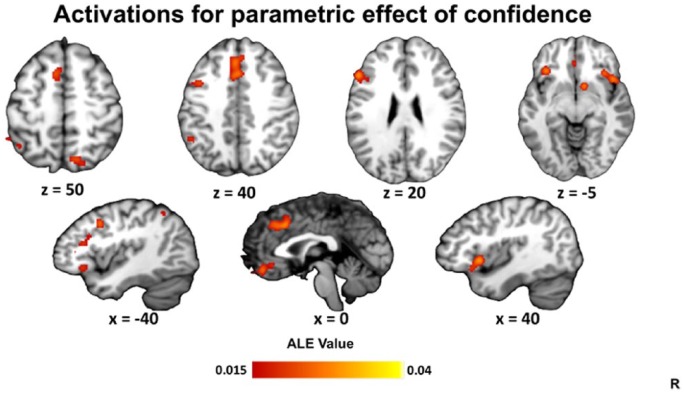
ALE results for parametric effects of confidence. Clusters are displayed
in MNI standard space. Multiple-comparisons correction was applied at
the cluster level at a family-wise error-corrected threshold of
p < .05, 5000 permutations, and a
cluster-defining threshold of p < .001
uncorrected.